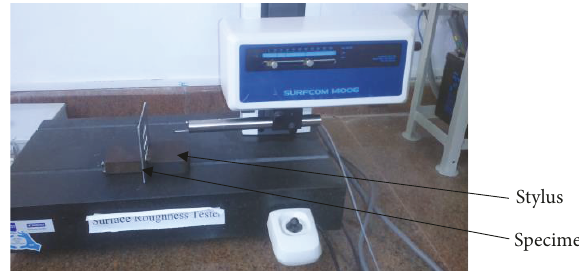
Figure 7: Measurement of surface